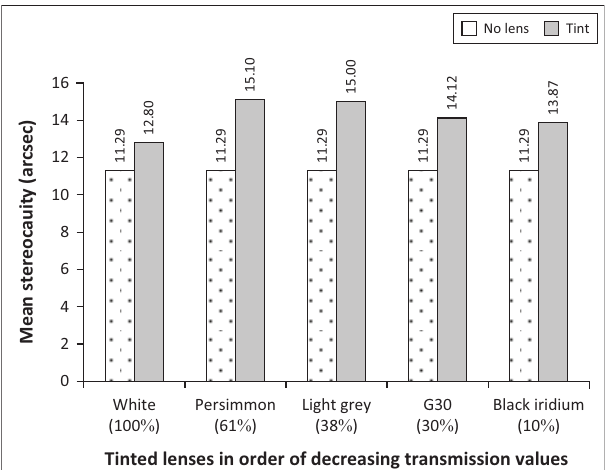
FIGURE 1: Mean distance stereoacuity under photopic conditions with no lens versus the tinted lenses.